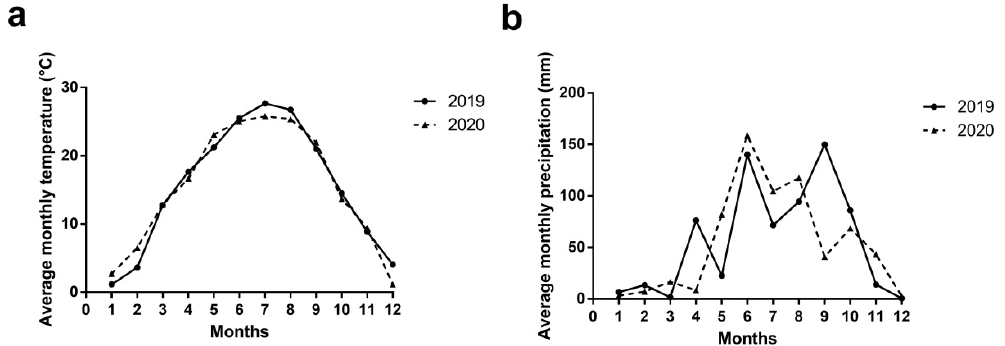
Figure 1. Average monthly temperature ( a ) and precipitation ( b ) obtained during 2019 and 2020. Notes: Data from China Statistical Yearbook.